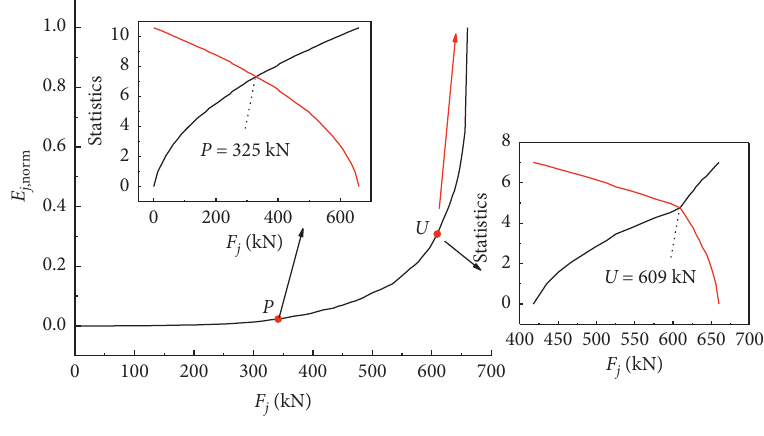
− F j, norm j curve of